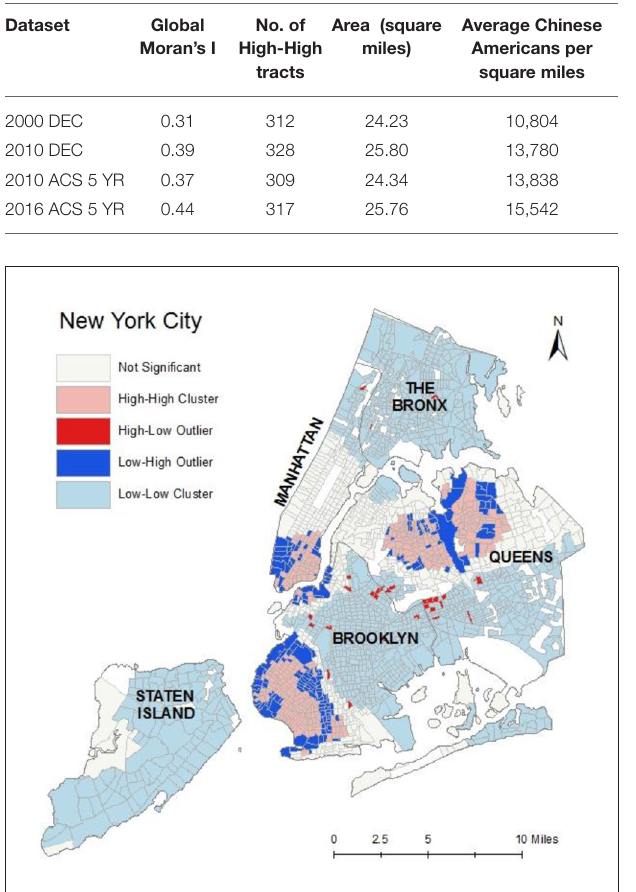
FIGURE 4 | The spatial distribution of Chinese American outliers and clusters, 2016.